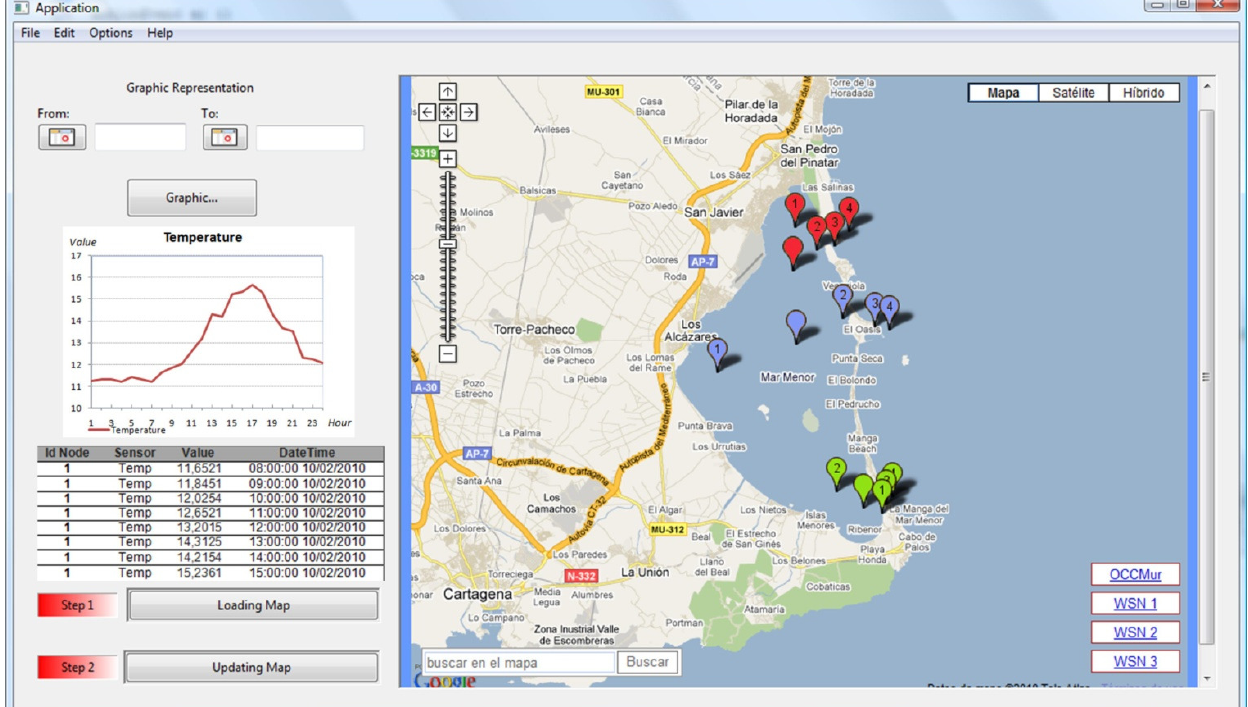
Figure 4. Example of an application for real-time monitoring of data from an oceanographic